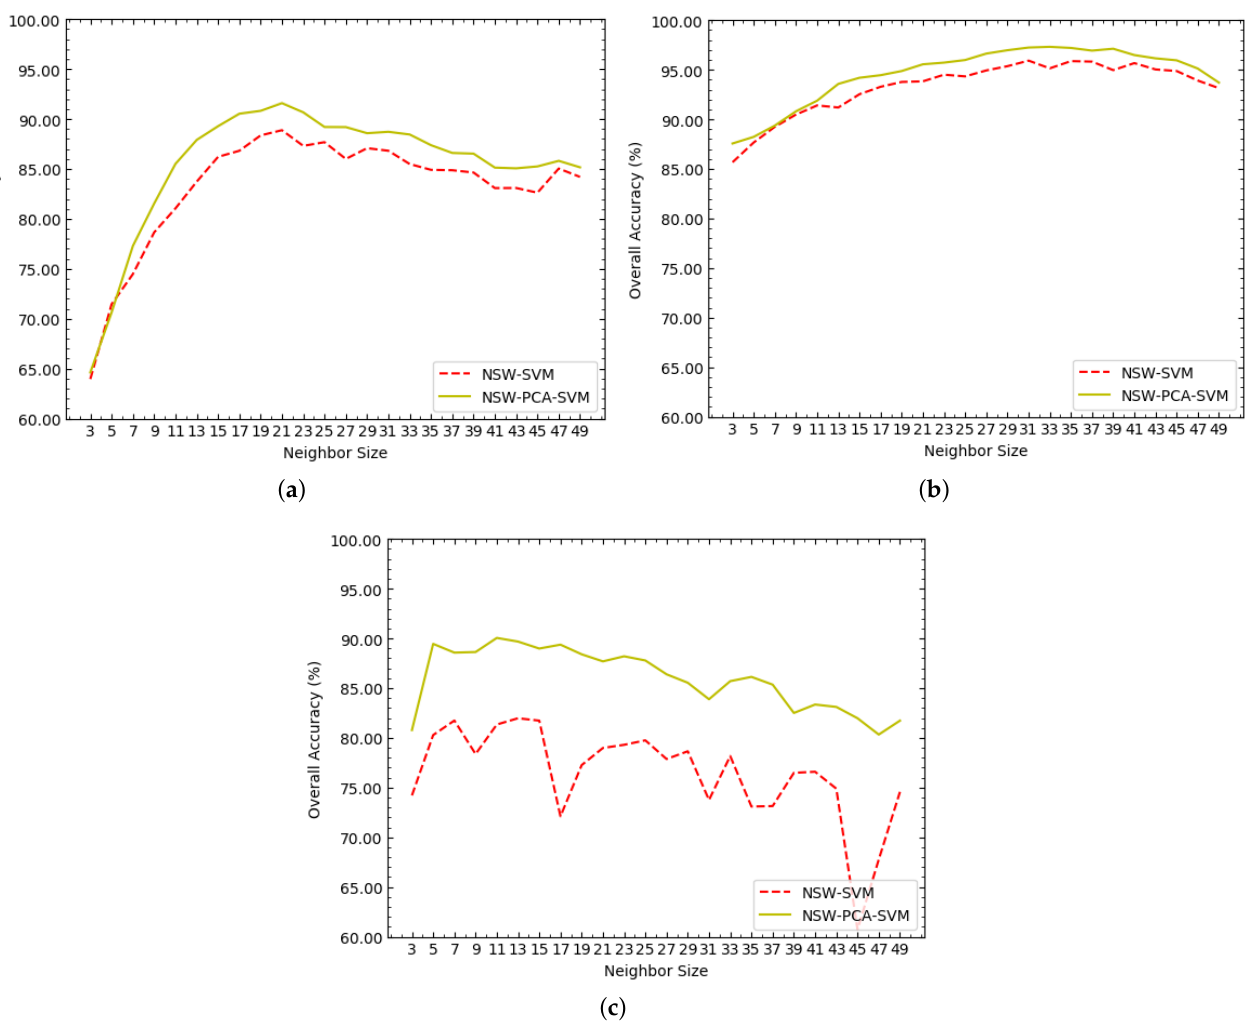
Figure 3. The overall accuracies (OAs) of NSW-SVM and NSW-PCA-SVM corresponding to different values of ω on the three datasets, where ( a – c ) represent the experimental results in Indian Pines, Salinas and PaviaU datasets,